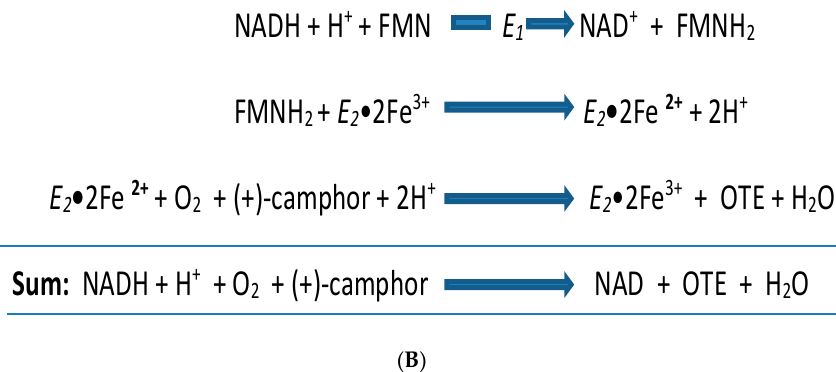
Figure 3. ( A ) Proposed [25] functional complex between E 1 (NADH oxidase) and E 2 (2,5-diketocamphane 1,2-monooxygenase); ( B ) Proposed [25] reaction sequence for the combined action of E 1 and E 2 .